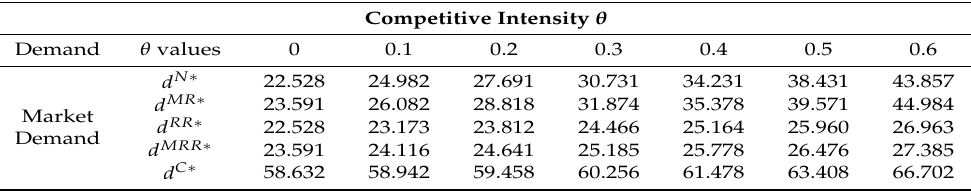
Table 4. The influence of competition intensity on the market demand.